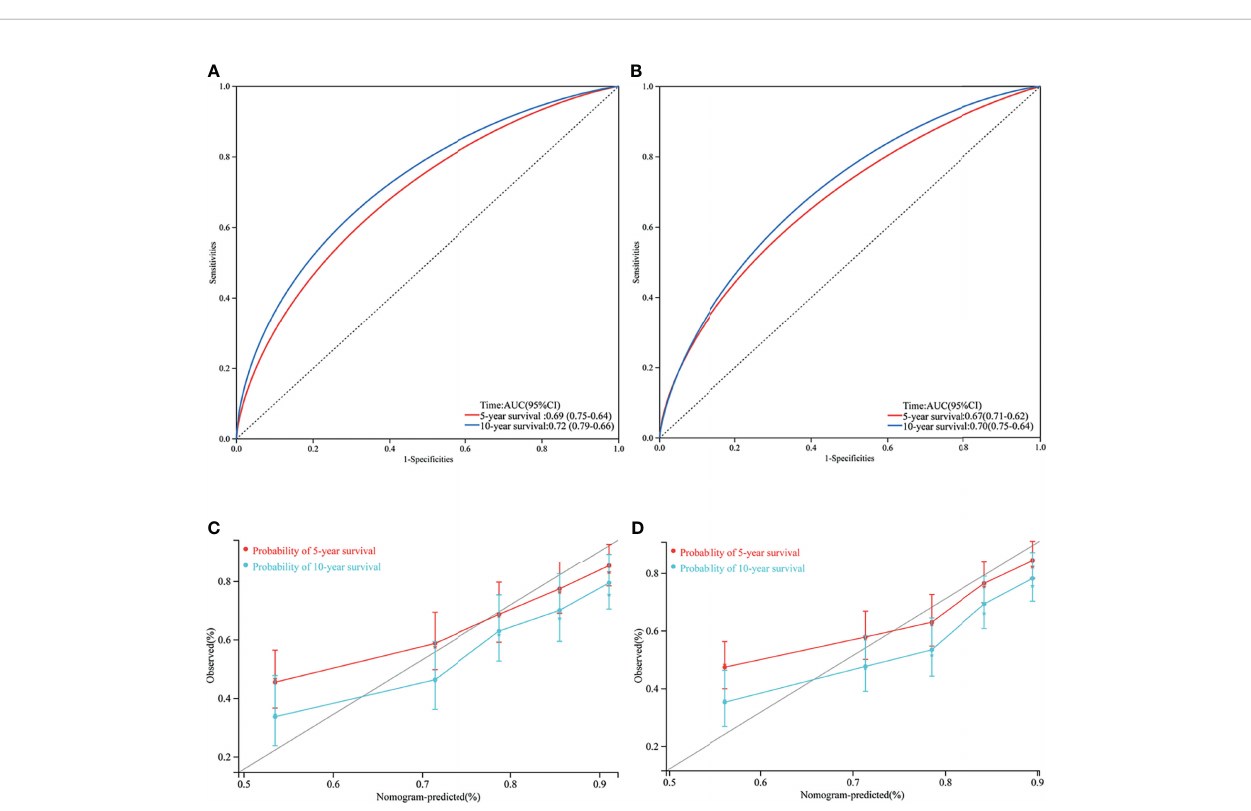
FIGURE 4 | Area under curve (AUC) of the training set (A) and validation set (B) ; 5- and 10- year cancer-speci fi c survival according to the training set (C) and the validation set (D) .